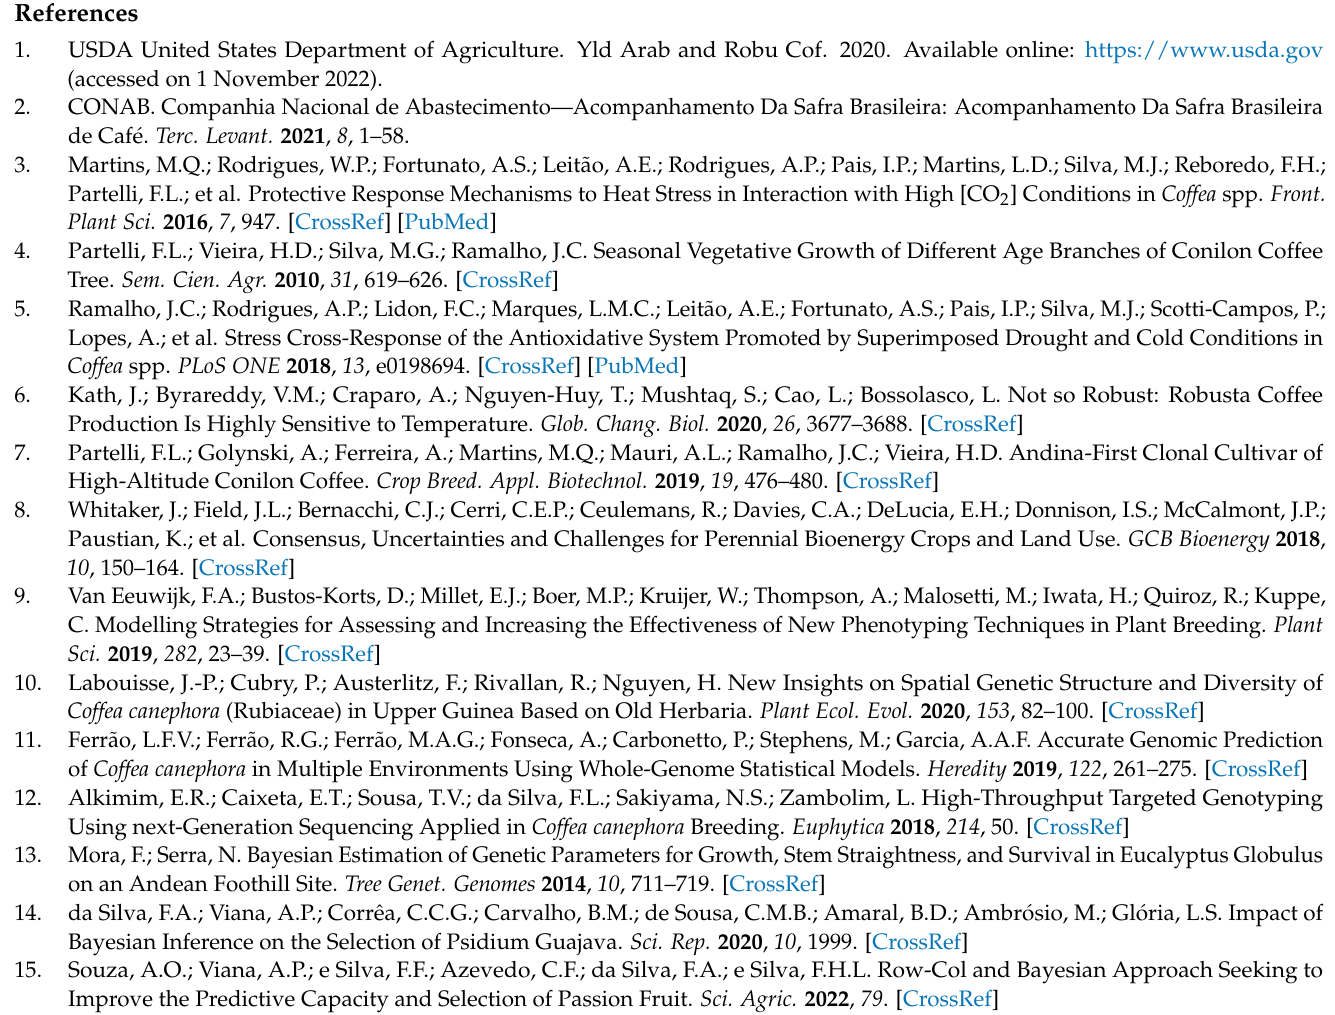
Figure A6. Distribution of residuals for each fitted value.